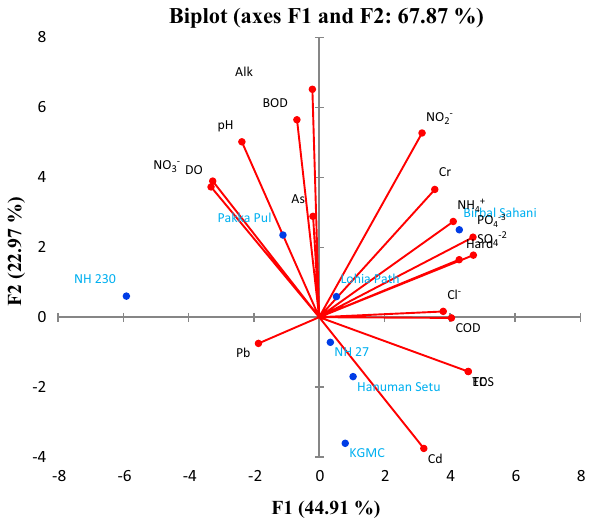
Fig. 6 Biplot between physiochemical parameters and sampling sites